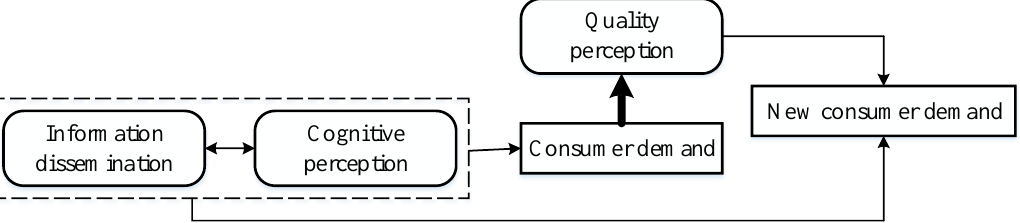
Figure 1. The relationship between cognitive and quality perception.